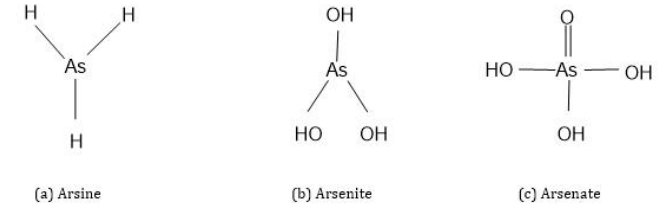
Figure 2. Chemical structures of inorganic arsenic species.